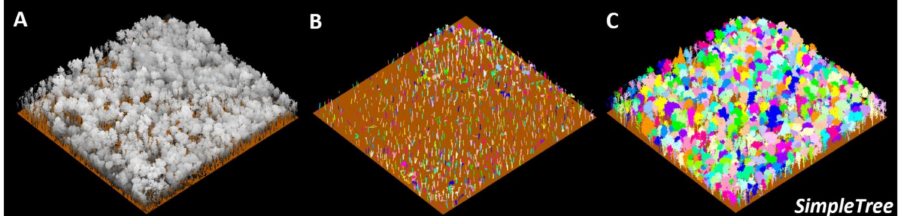
Figure 8. Summary of SimpleTree main steps that were applied on the 1 ha (+buffer) ULS-V point cloud (ULS-V-Pcloud): ( A ) initial point cloud with vegetation points isolated from the ground; ( B ) de- noising of a slice around the DBH and identification of individual tree stems; and ( C ) bottom-up tree